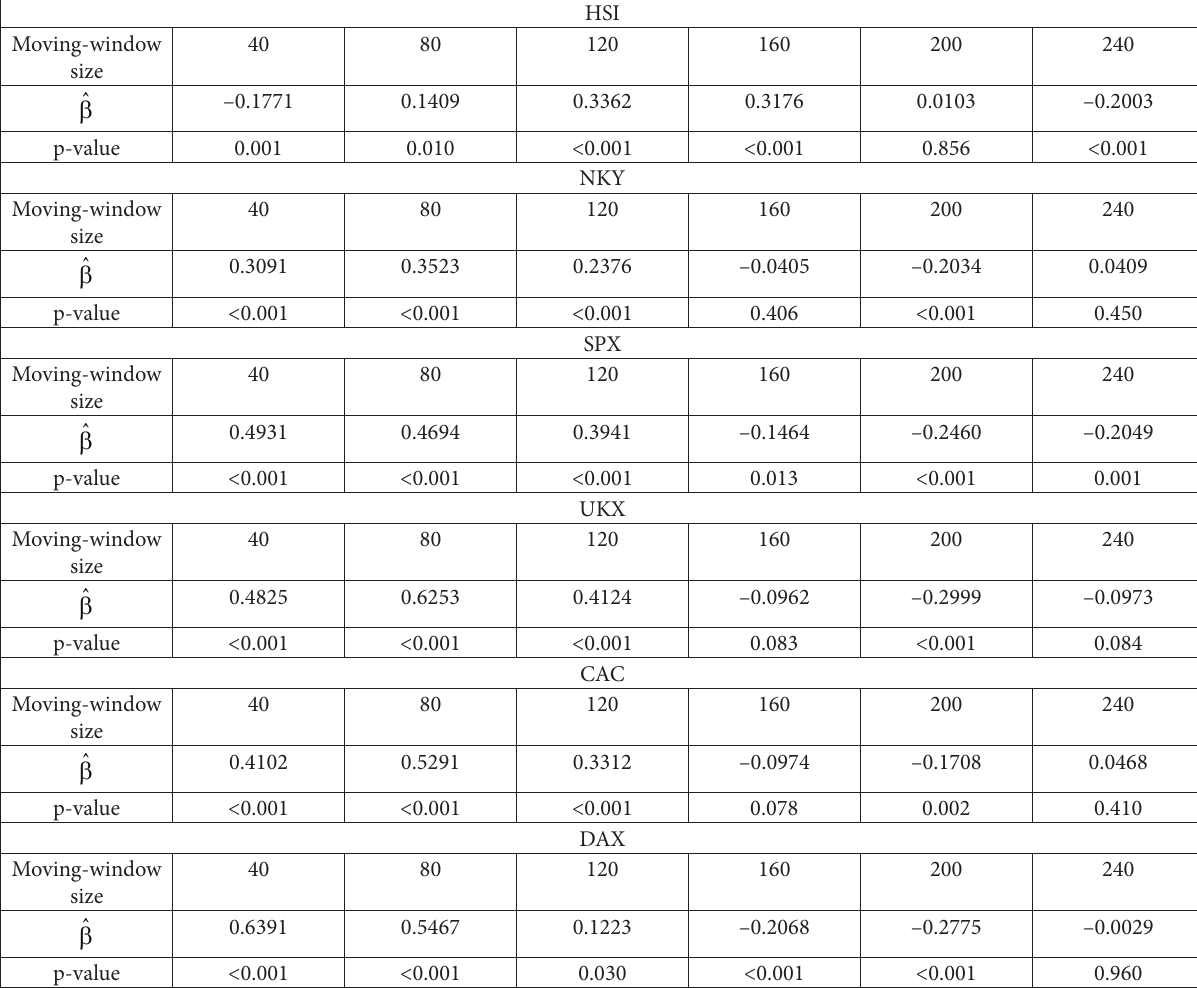
Table 11. The test results for the Halloween effect using Method